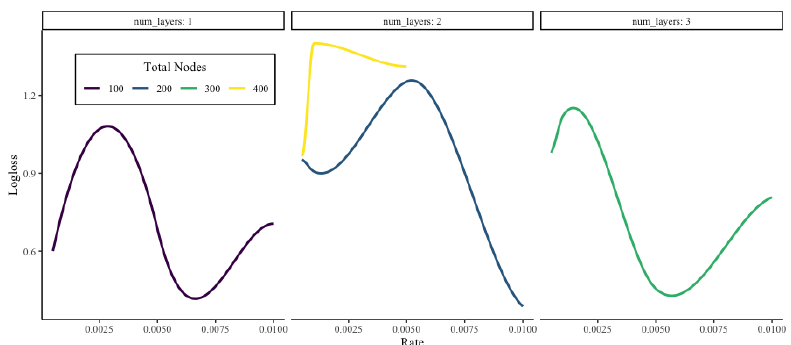
Figure 16. Visualization of the results from tuning deep learning models to predict claim frequency on the COLL data. Here, we show the change in logloss across different values of learning rate for the deep neural network. The left pane shows the results when there is one layer, the middle pane shows results when there are two layers, and the right pane shows there are three layers. The coloring of the points correspond to the total number of nodes in the neural